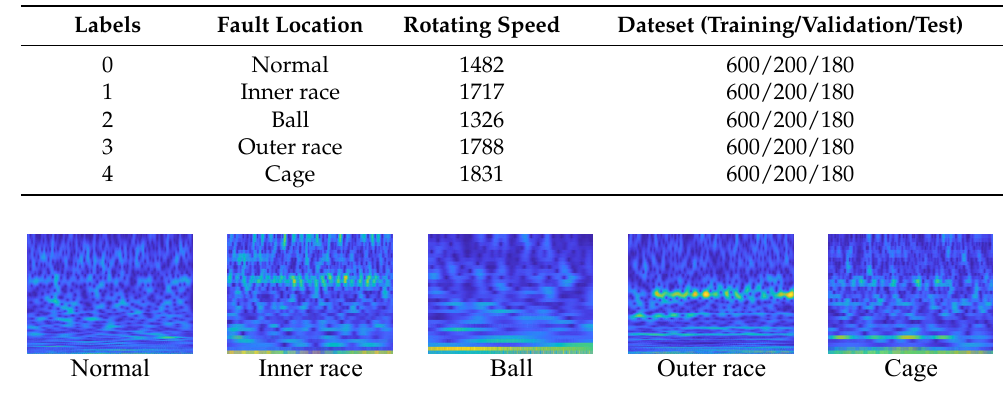
Figure 6. The time–frequency feature maps.